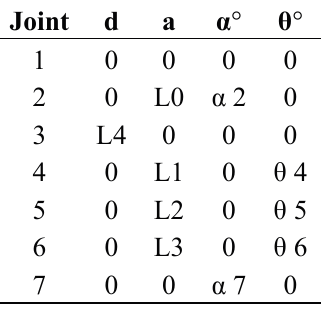
Table 4. Fixed D-H parameters for the robotic